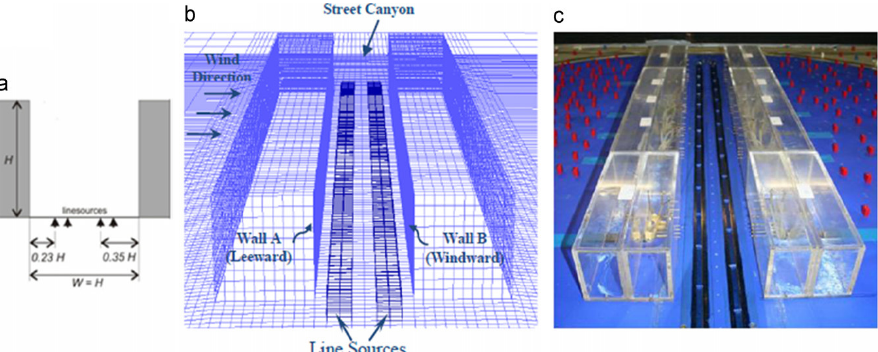
Figure 3. Illustrations on geometries and zones: ( a ) Outline of the locations of line sources inside the street canyon and the line sources presented for the ( b ) Computational Domain and ( c ) wind tun- nel setup [17–20] ©CODASC, KIT, https://www.umweltaerodynamik.de/bilder-originale/CODA/ CODASC.html (accessed on 20 June